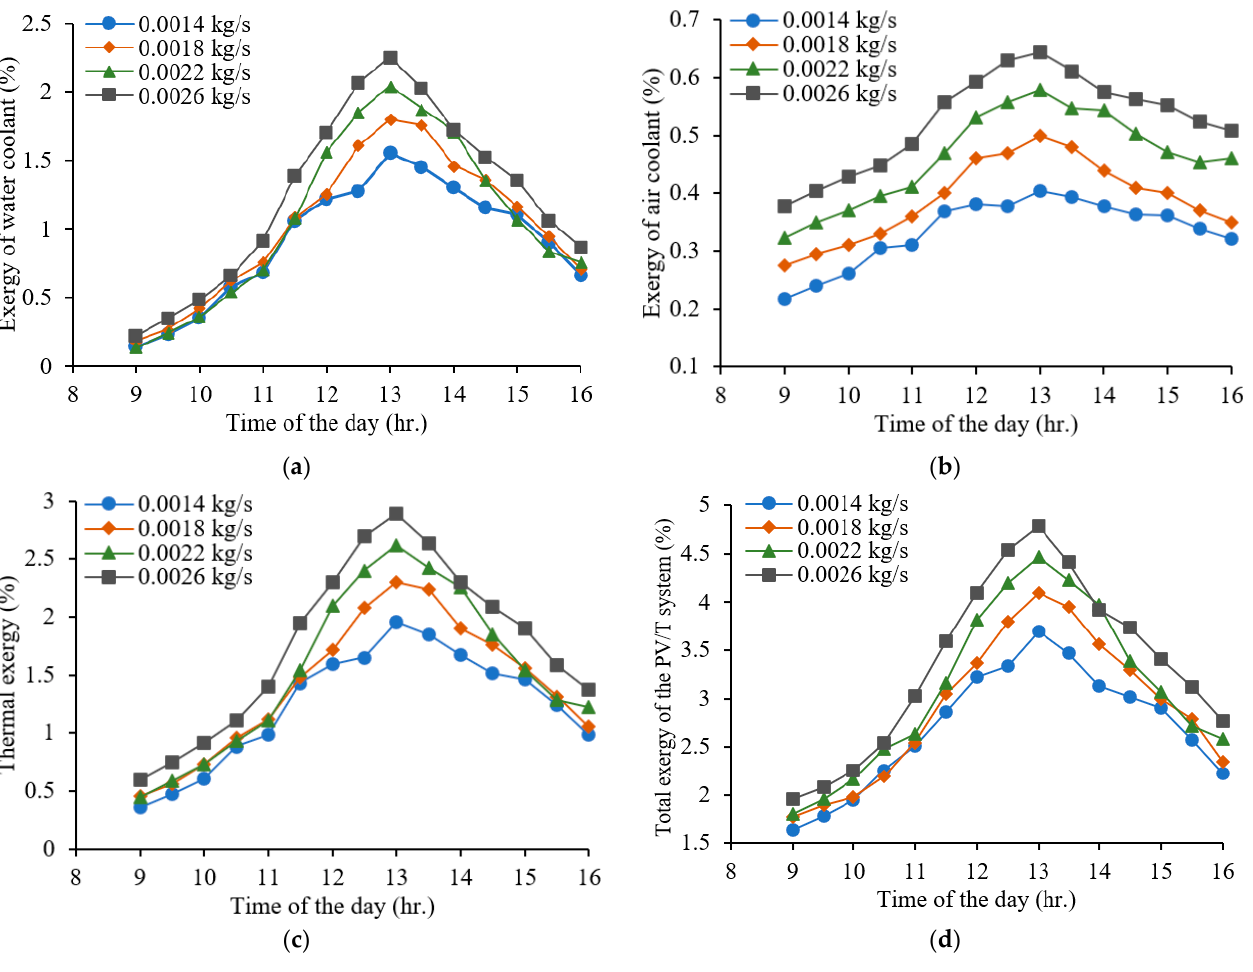
Figure 8. Variation of exergy efficiency at different mass flow rates for ( a ) water coolant, ( b ) air coolant, ( c ) thermal exergy, and ( d ) total exergy of the PV/T system.